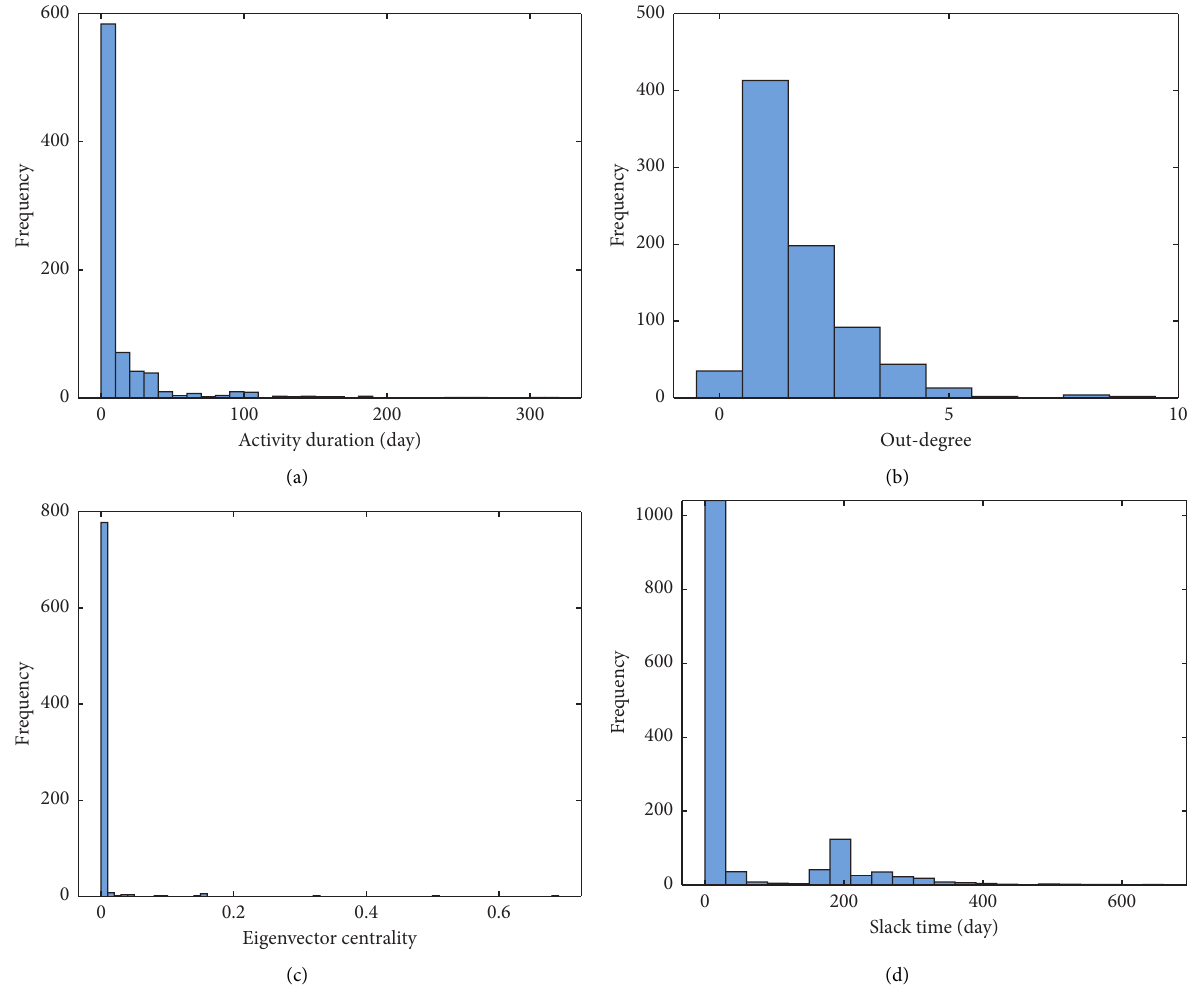
Figure 5: Data distribution: histogram of (a) duration, (b) out-degree, (c) eigenvectgor centrality, and (d) slack